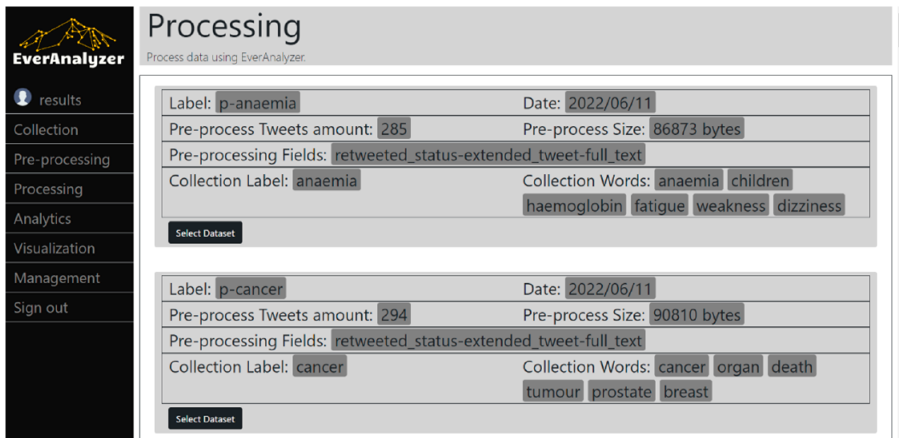
Figure 17. Processing Interface—Pre-processing datasets.